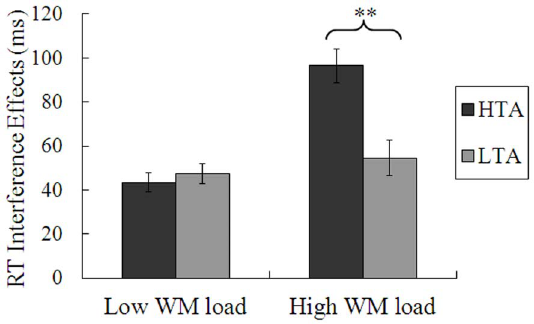
Figure 2. Interference effects (i.e., incongruent-congruent) on mean reaction times (RTs) under low or high working memory (WM) loads, for the high-trait-anxious (HTA) and low-trait- anxious (LTA) groups. Error bars represent standard errors of the means. ** p , .01.